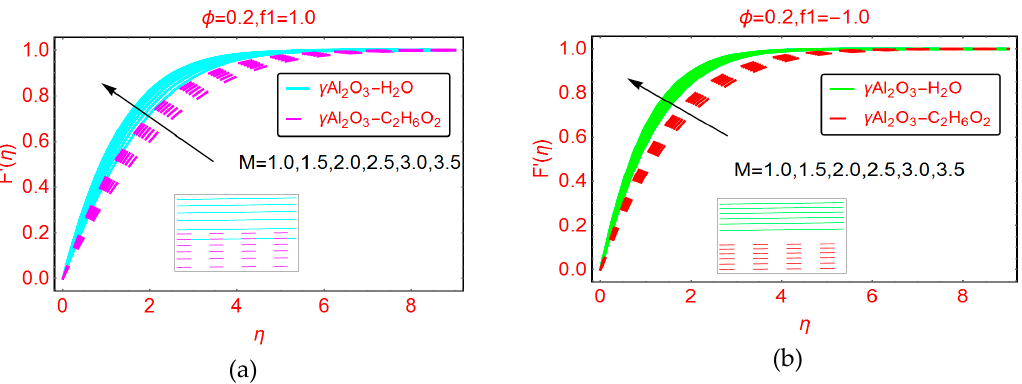
Figure 5. Effects of 𝑀 on the velocity profile 𝐹′(𝜂) for ( a ) 𝑓1 = 1.0 and ( b ) 𝑓1 = −1.0